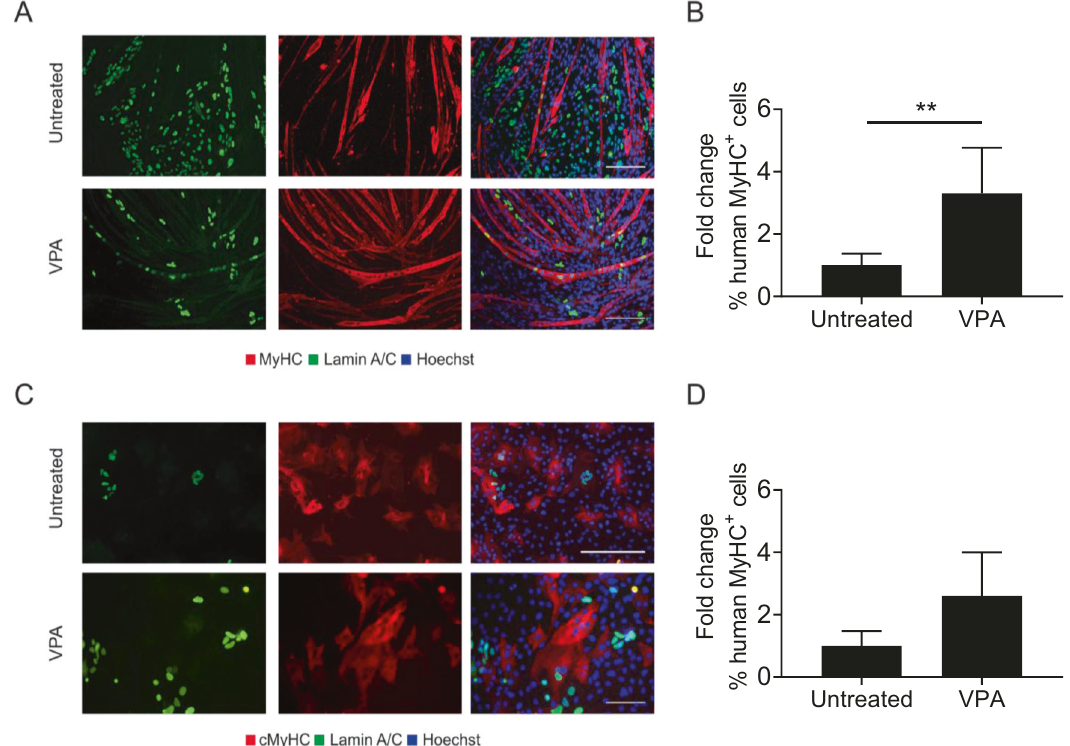
Fig. 5 Valproic acid increases the myogenic potential of mesodermal progenitors while maintaining the cardiogenic potential. A Immuno fl uorescence of lamin A/C-positive mesodermal progenitors (green), with or without exposure to valproic acid (VPA) in co-culture with C2C12 myoblasts. B Amount of lamin A/C-positive mesodermal progenitors positive for myosin heavy chain (MyHC), compared to the untreated condition ( n = 4). C Immuno fl uorescence of lamin A/C-positive mesodermal progenitors (green), with or without exposure to VPA, in co-culture with rat cardiomyocytes. D Amount of lamin A/C-positive cells positive for cardiac myosin heavy chain (cMyHC), compared to the untreated condition ( n = 3). Scale bar: 100 µm. *** P <